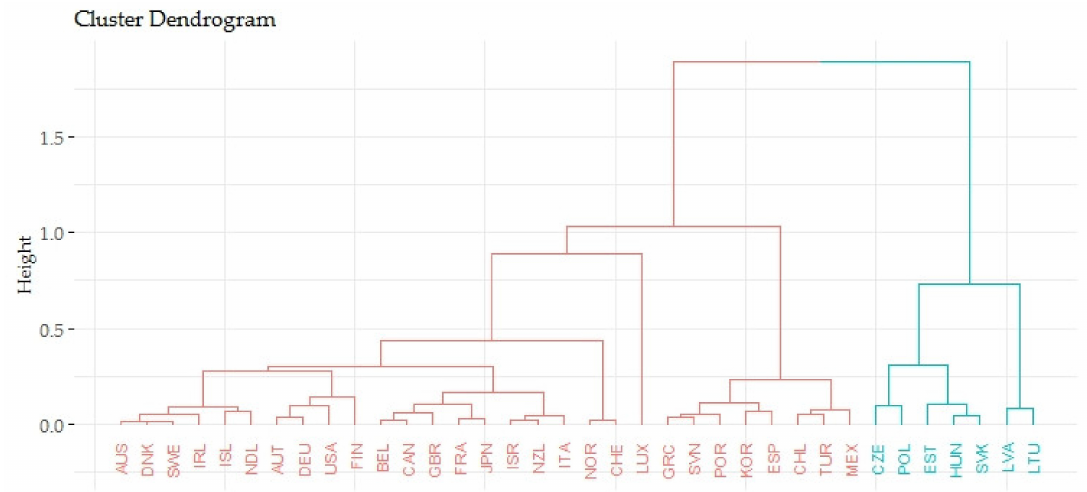
Figure 5. Hierarchical clusters of OECD countries—the relations of economic prosperity and gender inequalities in avoidable mortality.